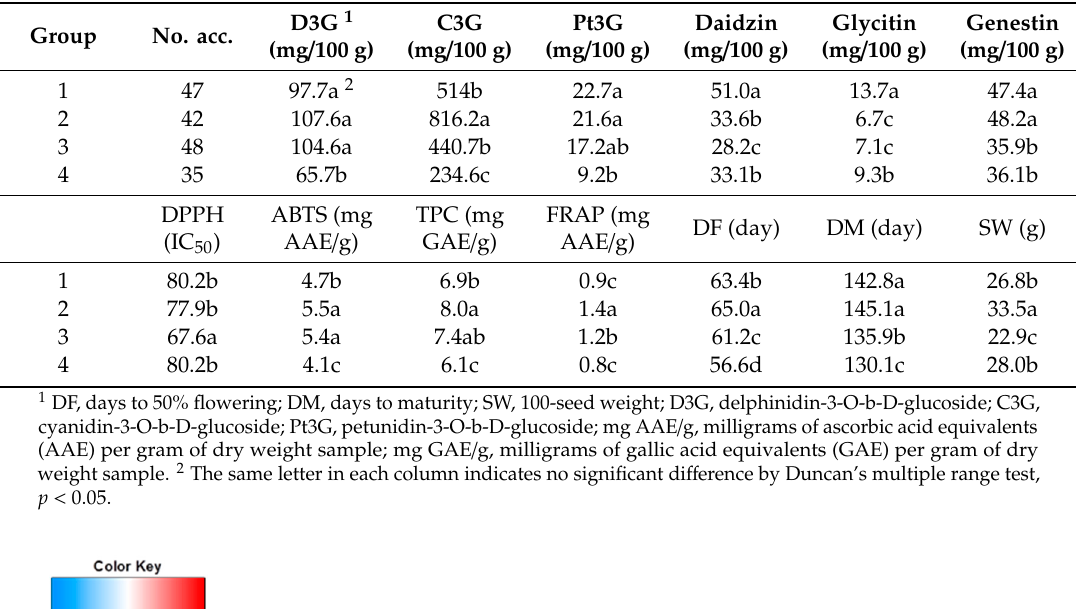
Table 5. Average cluster values of agricultural traits, phytochemicals, and antioxidant activities of 172 Korea black soybean landraces.